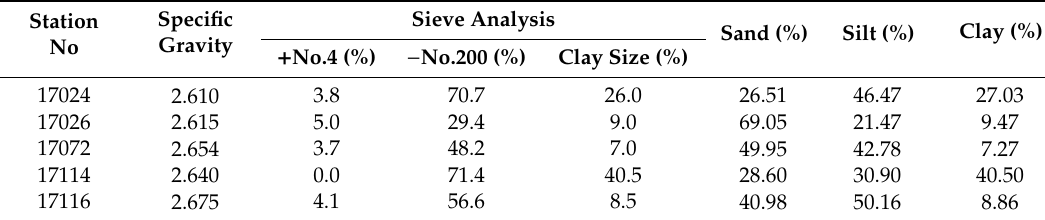
Table 2. Hydrometer test and sieve analysis results.